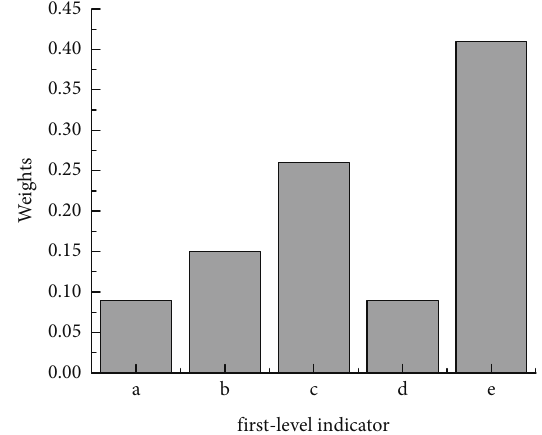
Figure 8: Weight value of fi rst-level